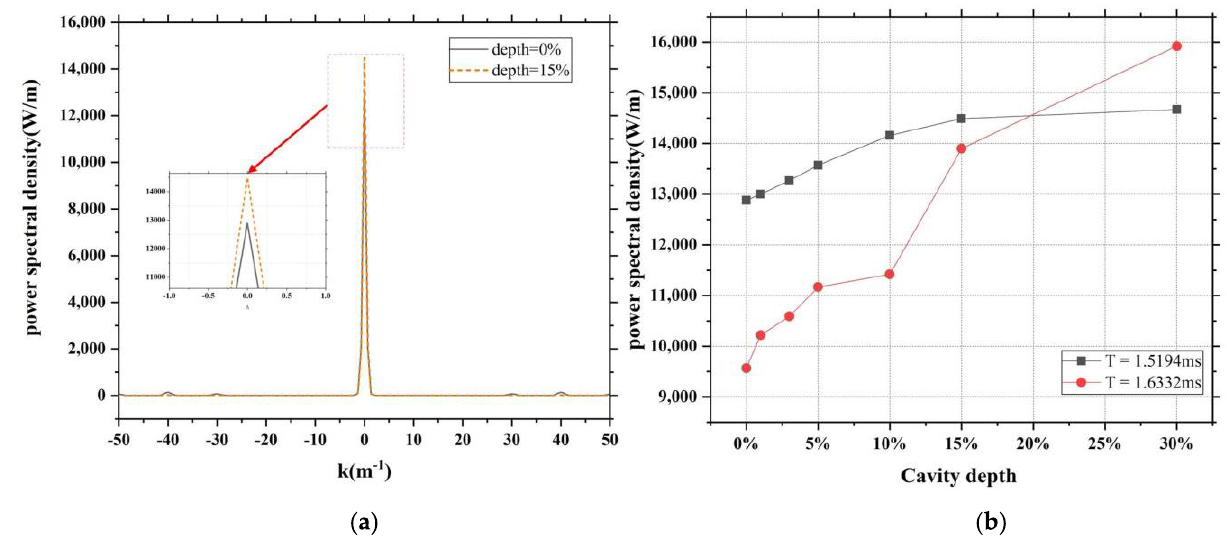
Figure 12. ( a ) Power spectral density on the height range of 266.85 − 267 km at 1.5194 ms with different cavity depths; ( b ) peak of the power spectral density as a function of the cavity depth on the height range of 266.85 − 267 km at different